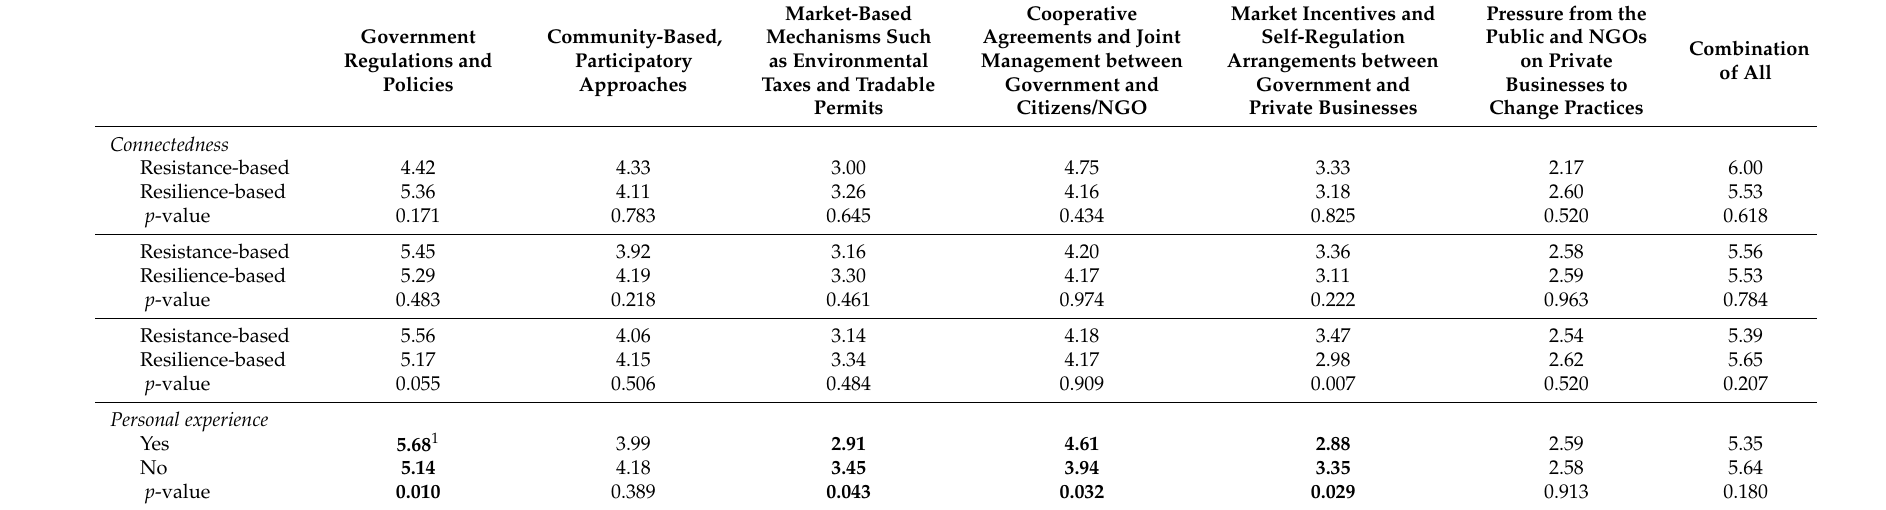
Pressure from the Public and NGOs Combination on Private of Businesses to Change Practices